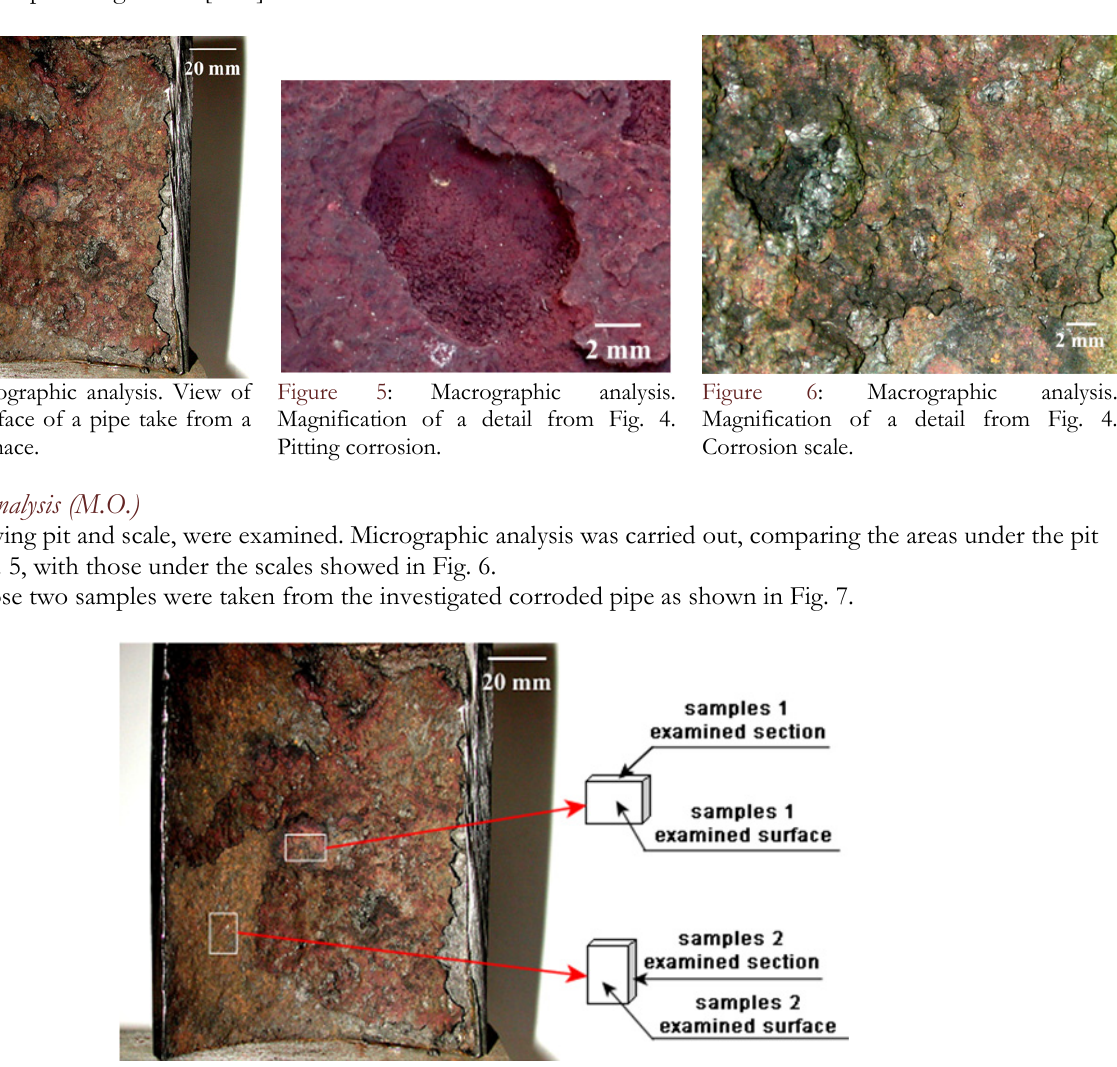
Figure 7: Areas of sampling; sample1: pit zone; sample2: scale